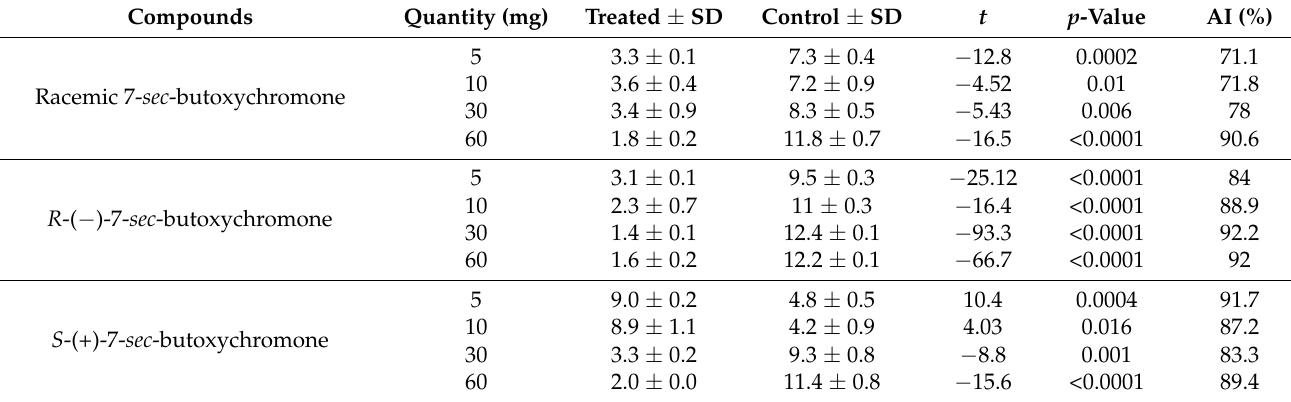
Table 16. T -test comparison of the averages number of mosquitoes in the two zones: control and treated with racemic 7- sec -butoxychromone ( 10 ), R -( − )-7- sec -butoxychromone ( 14 ), and S -(+)-7- sec -butoxychromone ( 15 ). Compounds Quantity (mg) Treated ± SD Control ± SD t p -Value AI (%)